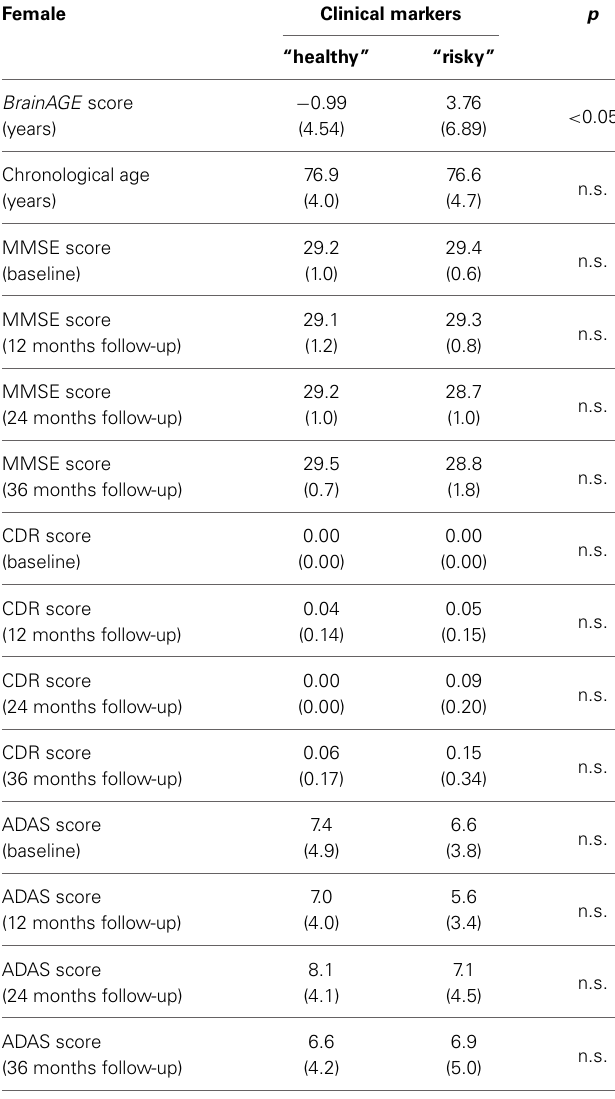
Table 7 | Means ( SD ) of BrainAGE scores, chronological age, and cognitive scores in female subjects with “healthy” clinical markers (i.e., values equal to or below the medians of GGT, ALT, AST, and values equal to or above the median of vitamin B 12 ) vs. “risky” clinical markers (i.e., values equal to or above the medians of GGT, ALT, AST, and values equal to or below the median of vitamin B 12